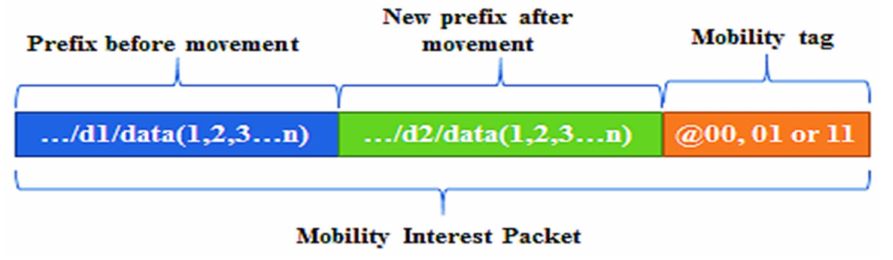
Figure 2. Mobility interest